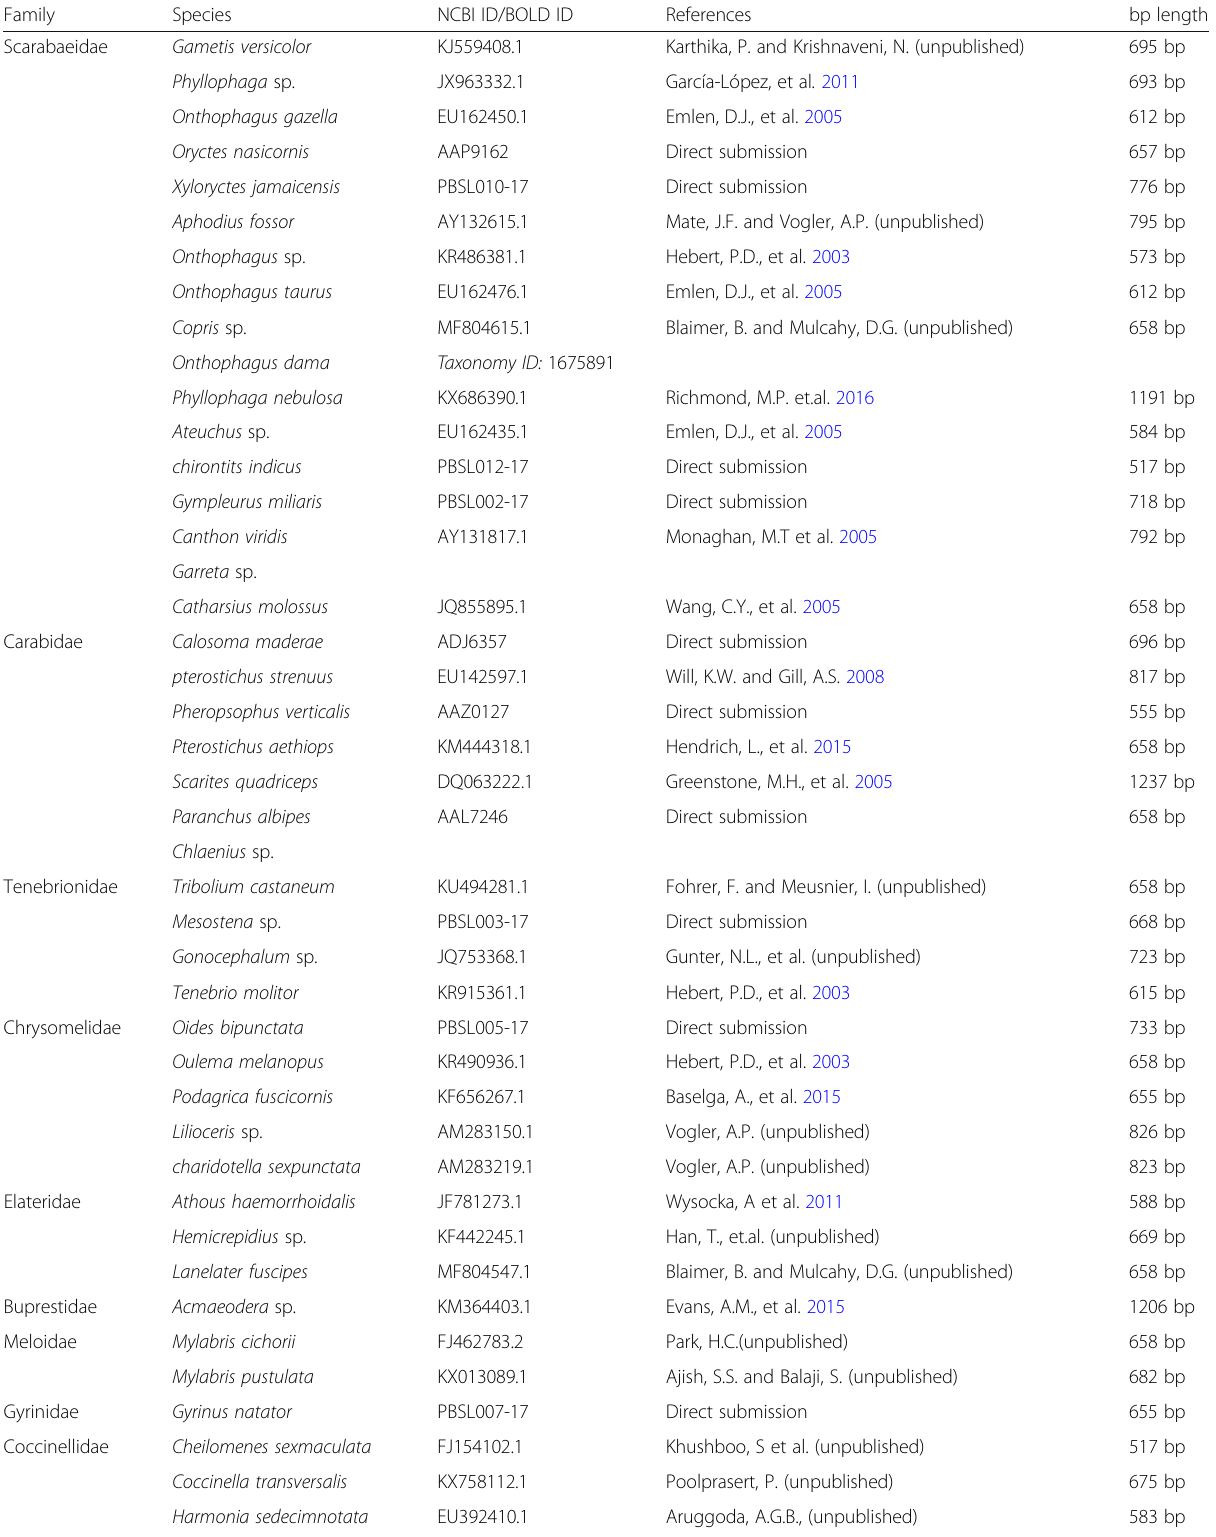
Table 3 Families of Coleoptera with their species submitted to NCBI along with its extension numbers by different authors used in the present